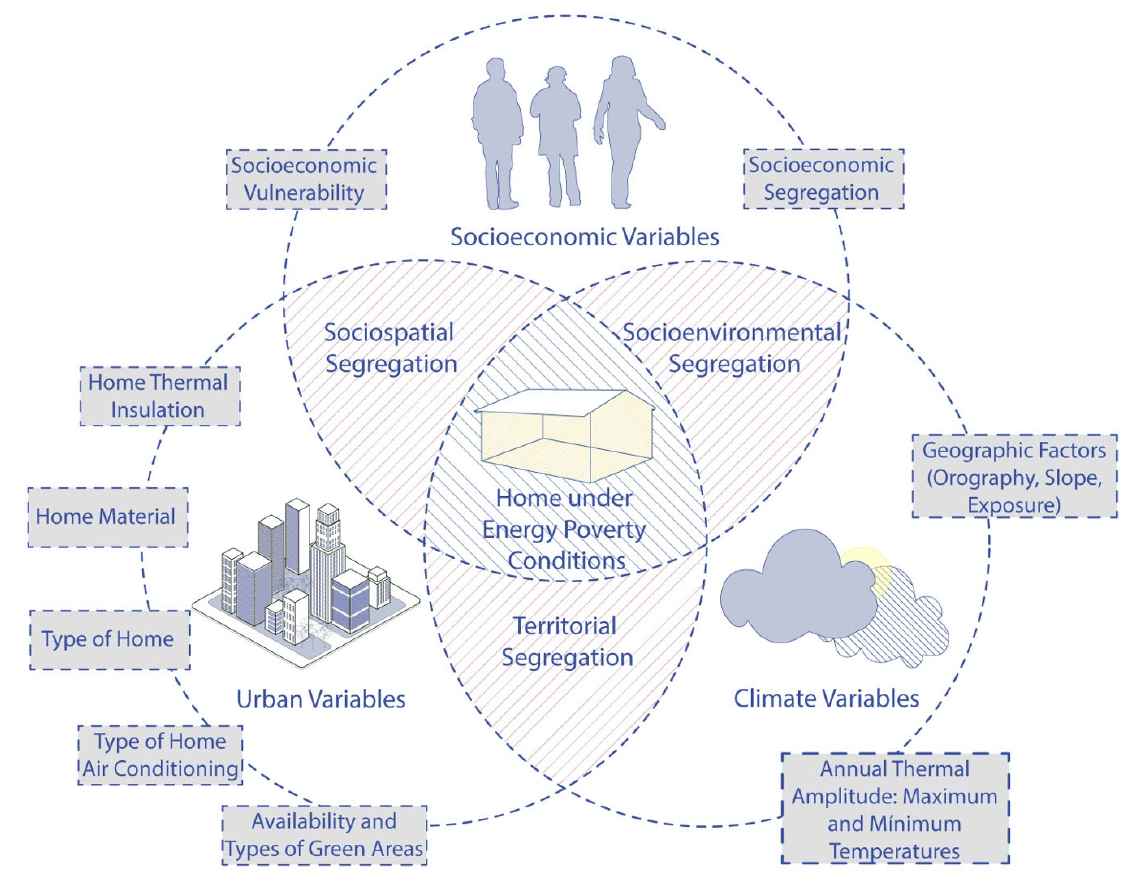
Figure 10. Diagram of interactions between the different areas of socioeconomic, urban, and climatic variables to explain the situation of housing in energy poverty.